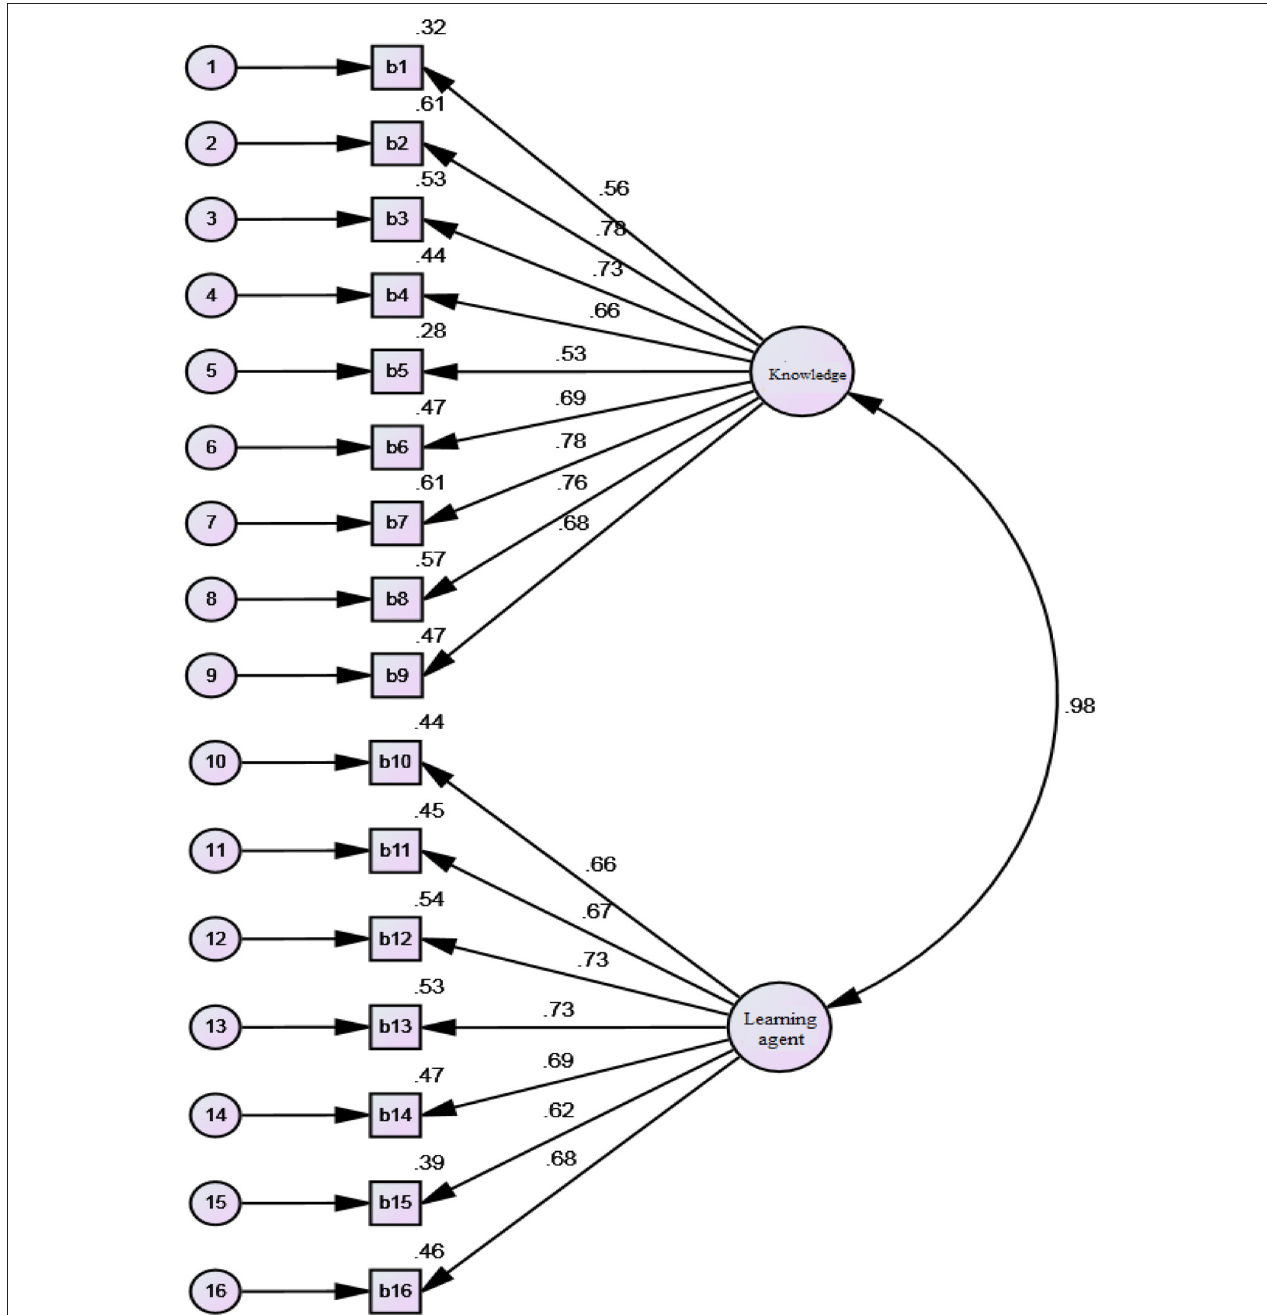
FIGURE 3 | Standardized ( β ) coefficients for CFA analysis and error variance of